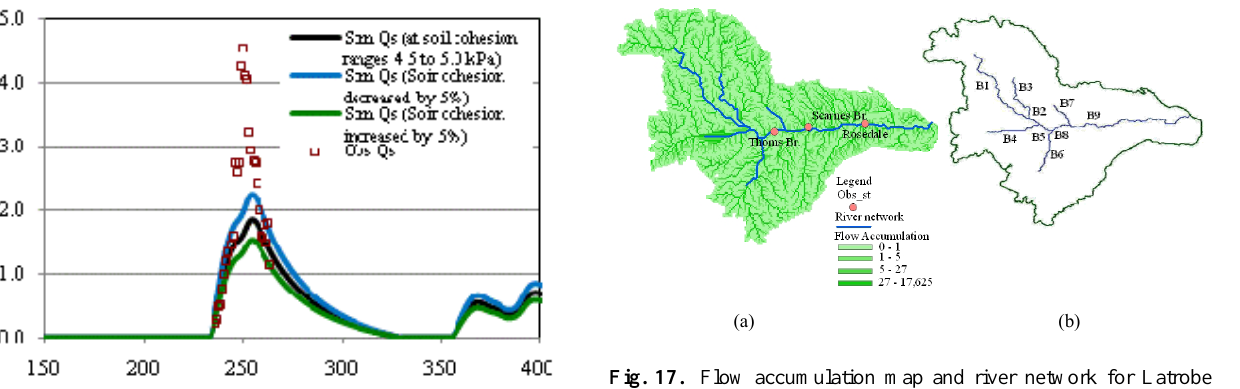
Fig. 18. Water discharge at Rosedale with basin avg. rainfall (ML=Mega liters).